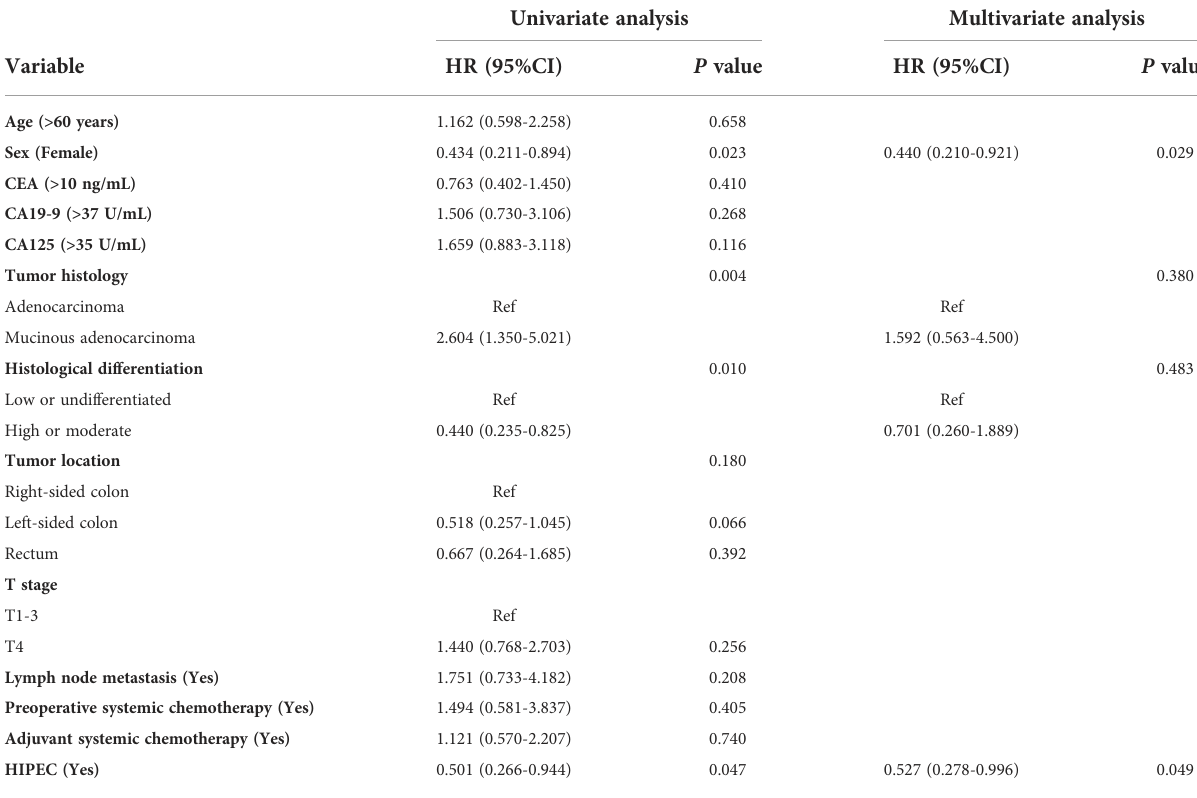
TABLE 3 Univariate and multivariate analyses for RFS of CRC patients with isolated synchronous colorectal peritoneal metastases using the Cox proportional hazards